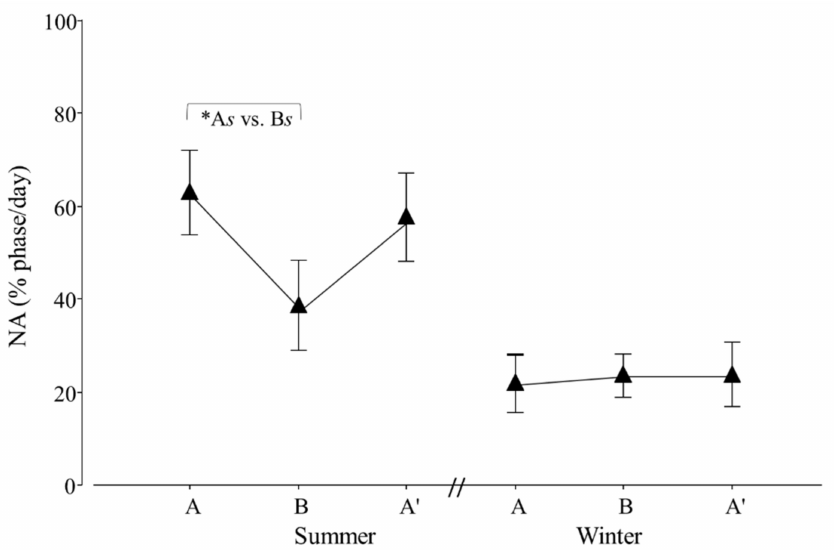
Figure 8. Percentage of nocturnal (NA) activity per day of adult Tamandua tetradactyla ( n = 6 females and 6 males) exposed to semi-controlled conditions, in response to transport (applied in B) during summer and winter. The ABA experimental design applied: day 0 (previous-stage A), days 1 and 2 (disturbance—stage B) and day 3 (posterior-stage A (cid:48) ). Behaviour was recorded every 5 min (252 records/day/individual), and the percentage of activity during dark phase per day during each stage was calculated. Asterisk indicates a significant difference between stages during summer for all individuals (* A s (cid:54) = B s ; p value in the text). Results are expressed as the mean ±